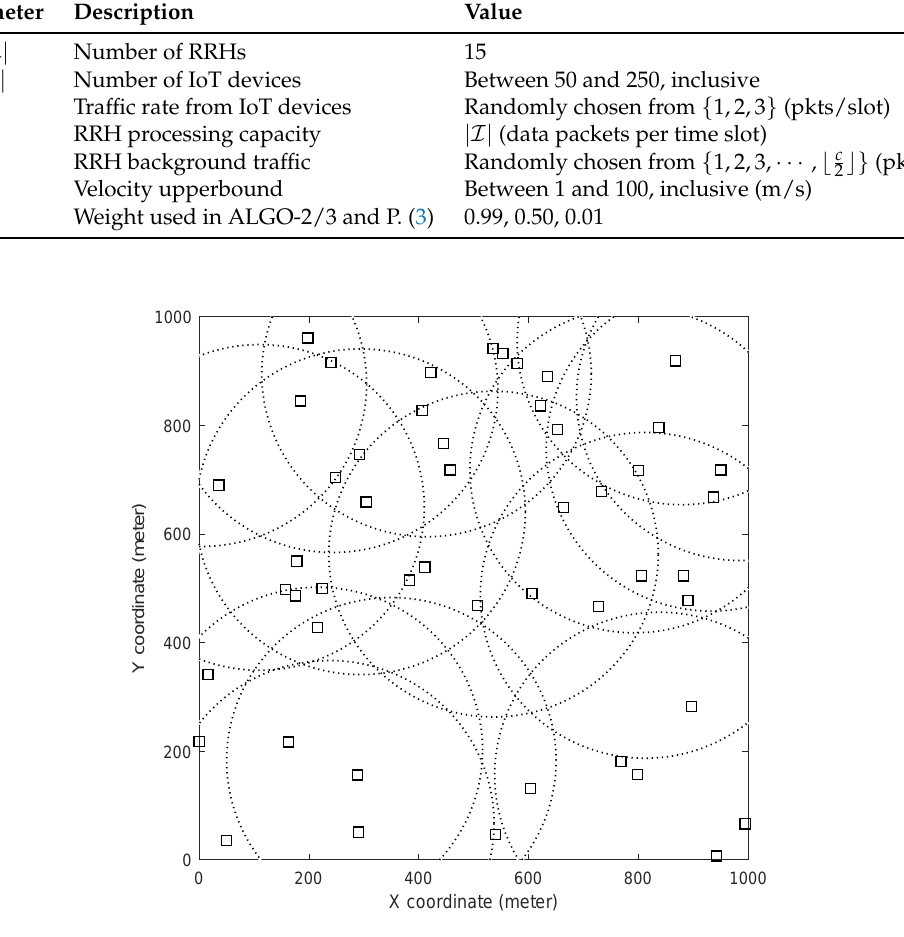
Figure 3. The initial layout of the network with 15 RRHs and 50 IoT devices. Dotted lines indicate the transmission ranges of RRHs and the empty rectangles indicate the initial positions of the IoT